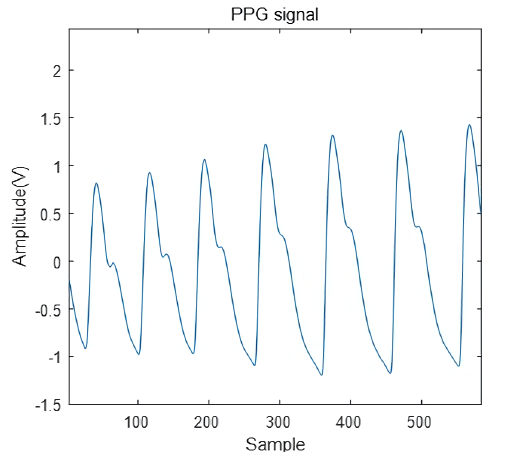
Figure 3. Raw photoplethysmogram (PPG)